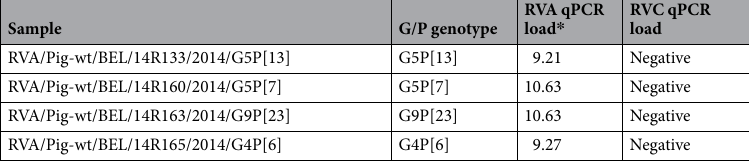
Table 1. RT-qPCR diagnosis of rotavirus fecal suspensions 7 . * Is RT-qPCR titer: log10 copies/g